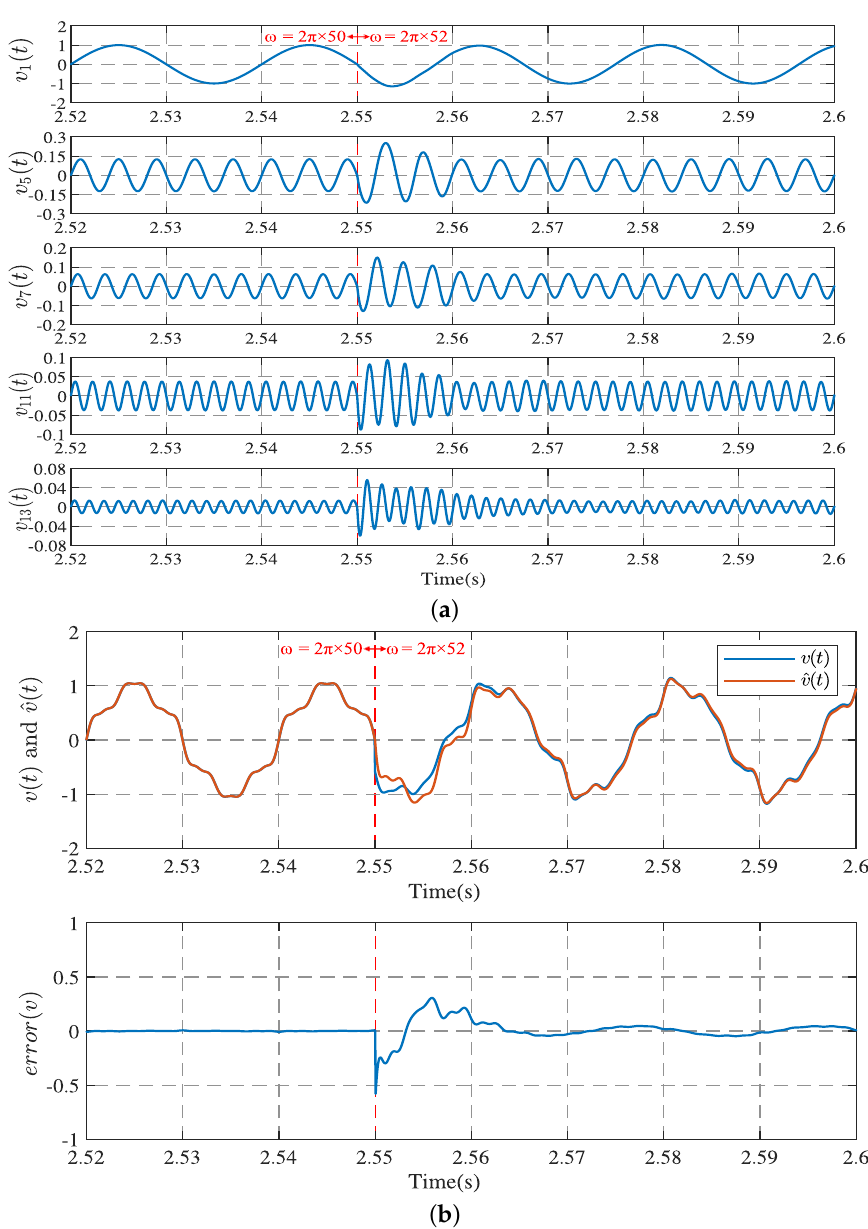
Figure 7. Real-time simulation results: ( a ); The effect of extracting each harmonic after the jump in the fundamental frequency of the input signal; ( b ) Comparison of the observer results with the real signal and the error